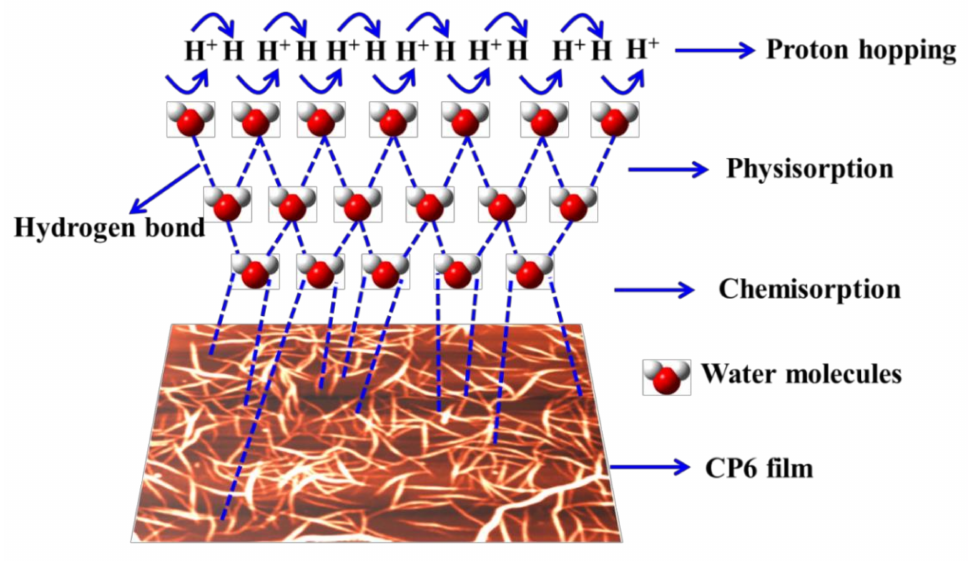
Figure 5. Proposed humidity sensing